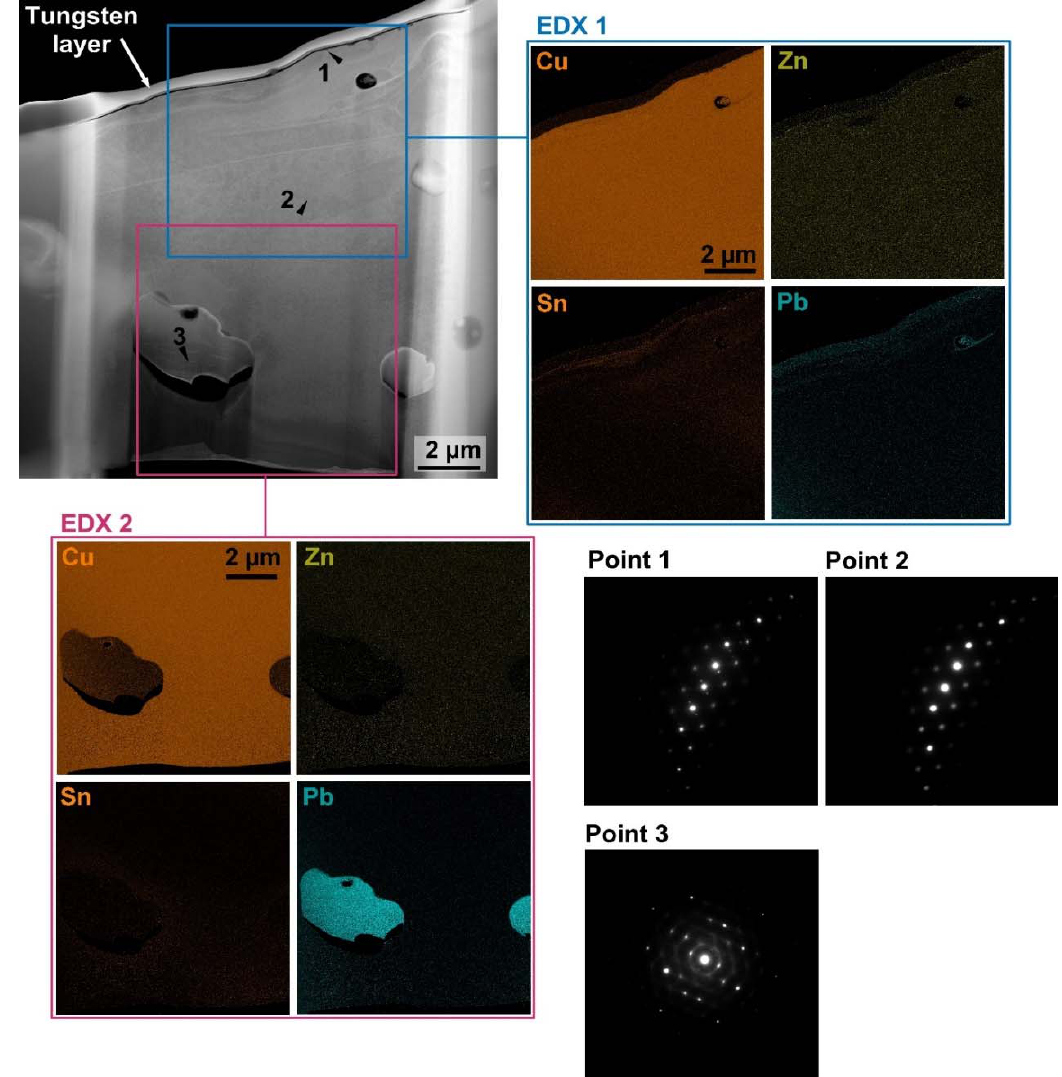
Figure 9. TEM lamella with two EDX measurement points and three other diffraction measurement points, Point 1—the recast layer point, Point 2—the base material point, Point 3—the lead particle.